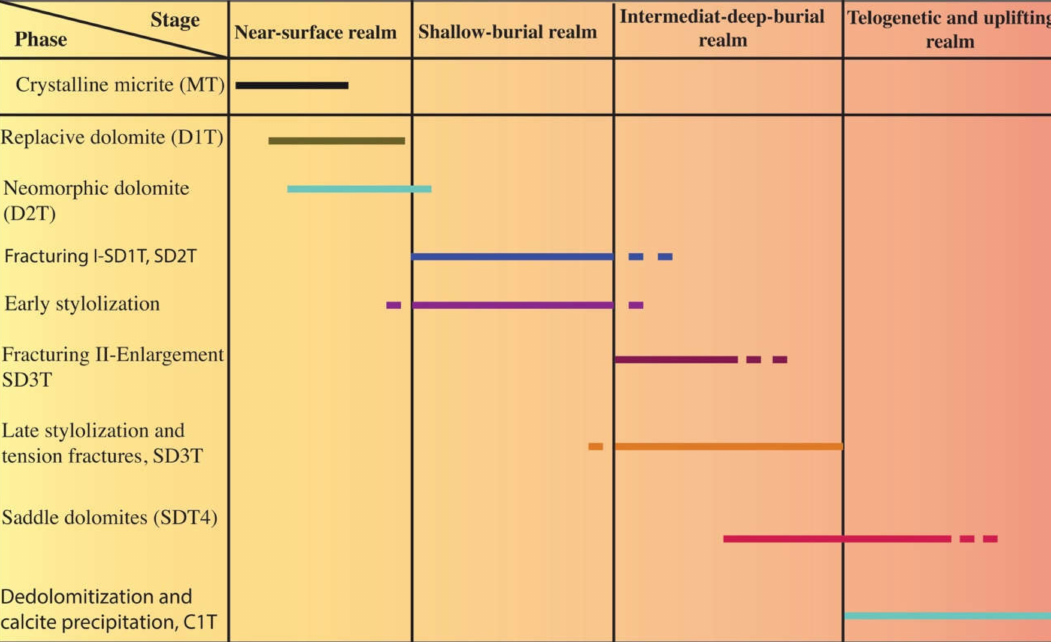
Figure 11. Paragenetic succession illustrating the diagenetic phases of Triassic section. Provençal Domain, SE France (see text for